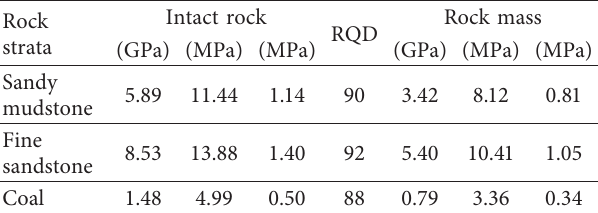
Table 1: Intact rock properties and calculated rock mass